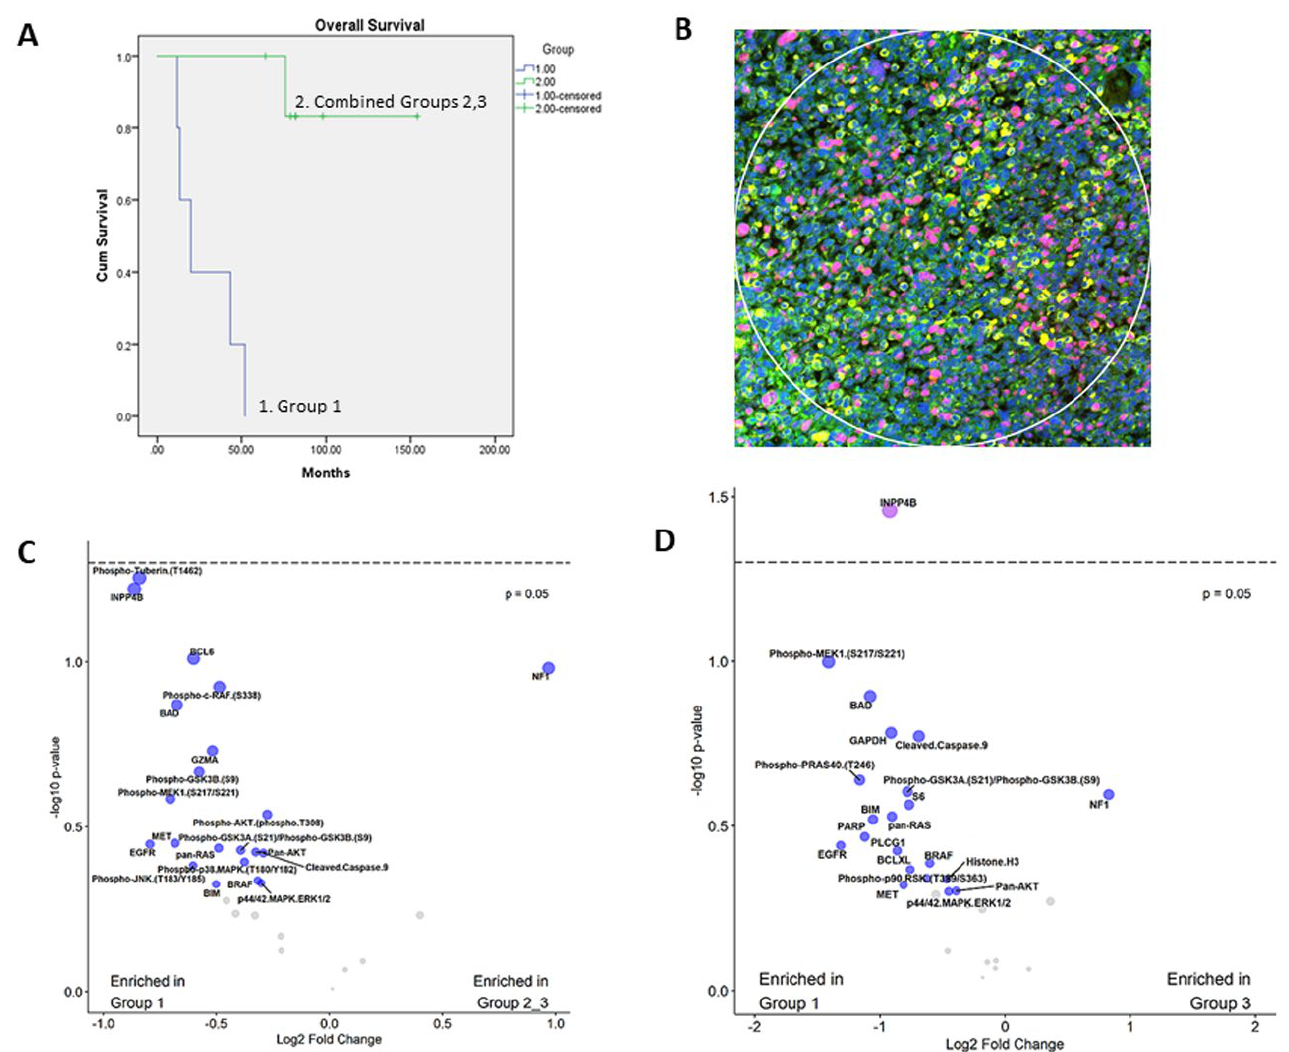
Figure 1. Differences between Group 1 and Group 2 patients in overall survival and expression of pathway members: ( A ) Kaplan–Meier survival plot reveals significant difference in overall survival between Group 1 and Group 2, 3 (combined) patients. ( B ) A representative image of a region of interest (ROI). ROIs were selected based on immunofluorescence staining with desmin (yellow), Ki-67 (red), cytokeratin (green-absent) and DNA (blue). ( C ) A volcano plot showing differential expression of analytes and comparison between Group 1 and Groups 2 and 3 tumors (combined), as measured by DSP. ( D ) A volcano plot showing differential expression of analytes and comparison between Group 1 and Group 3 tumors, as measured by DSP. Dotted line represents cut-off p -value of 0.05. Gray dots represent remaining analytes with no significant differences.